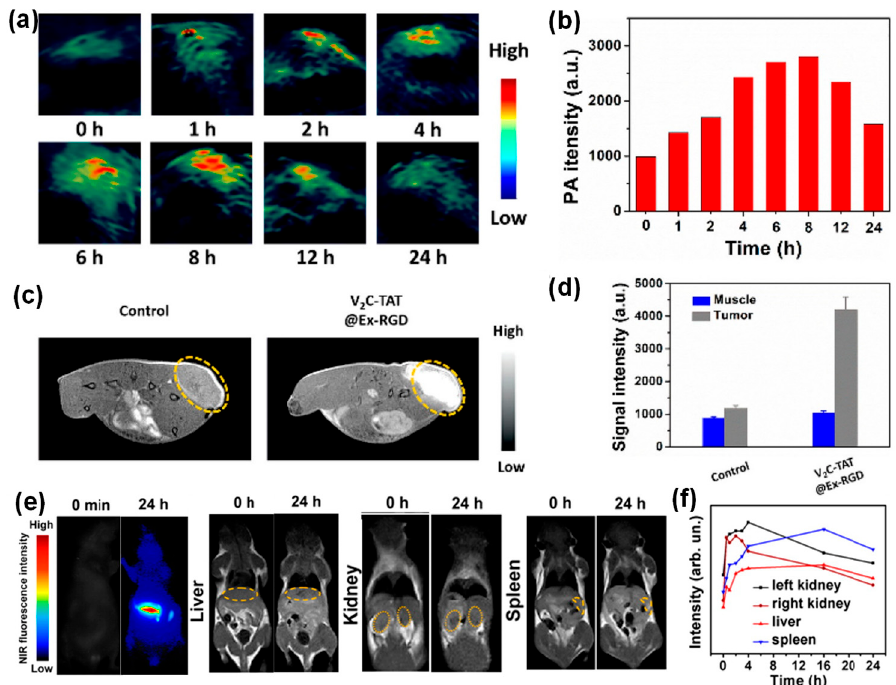
Figure 5. Dual imaging modalities with inorganic nanoparticle-loaded exosomes: ( a – d ) in vivo imaging of MCF-7 breast tumor-bearing mice after intravenous injection of V 2 C QD-loaded exosomes ( a , b ) PA images and quantified PA intensities of tumor sites at different times, ( c , d ) T1 -weighted MR images and quantified MR signals of tumor sites 24 h post injection [30]. ( e ) NIR fluorescence and T1 -weighted images of mouse liver, kidneys, and spleen at 0 h and 24 h post injection of Ag 2 Se@Mn QD-labeled exosomes. ( f ) MR signal quantification in mouse liver, kidneys, and spleen after injection of Ag 2 Se@Mn QD-labeled exosomes